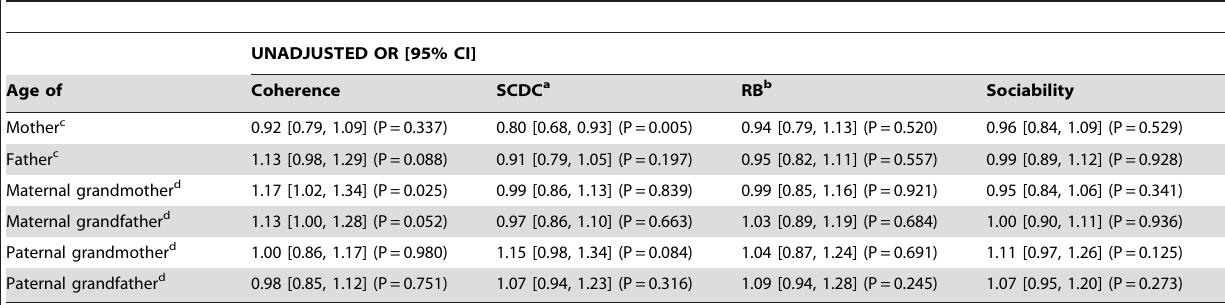
Table 3. Increase in risk [95% confidence interval] of child being in the worst decile of each autistic trait for each 10 year increase in age of parents and grandparents adjusted for gender.